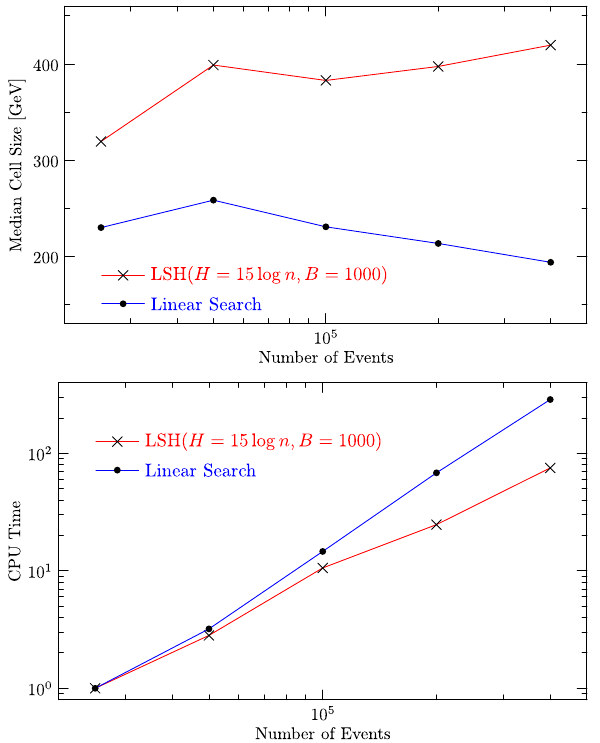
Fig. 3 Comparison between linear nearest-neighbour search and the LSH-based approach with H = 15log n hash functions and buckets containing B = 1000events.Theupperpanelshowsthemediancellsize as a function of the number of input events. The lower panel illustrates the scaling of the computing time with the sample size. The respective timings are normalised to the first data point in order to facilitate com- parison and eliminate constant factors resulting from differences in the implementation